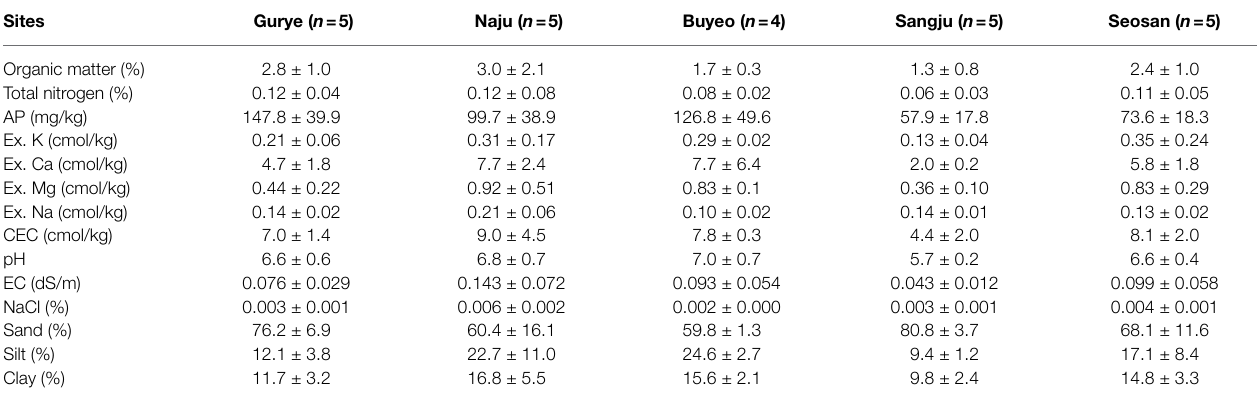
TABLE 1 | Chemical and physical properties of soils in the sampling areas. Sites Gurye ( n = 5) Naju ( n = 5) Buyeo ( n = 4) Organic matter